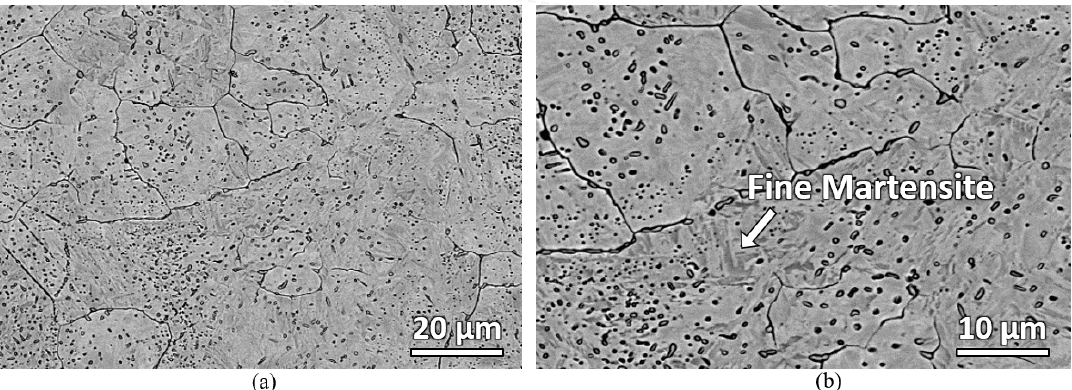
Figure 12. Backscattered electron micrographs of the water-quenched furnace-heated sample at bulk carbon location showing carbides distributed on fine martensitic and retained austenite matrix: ( a ) lower magnification and ( b ) higher magnification.